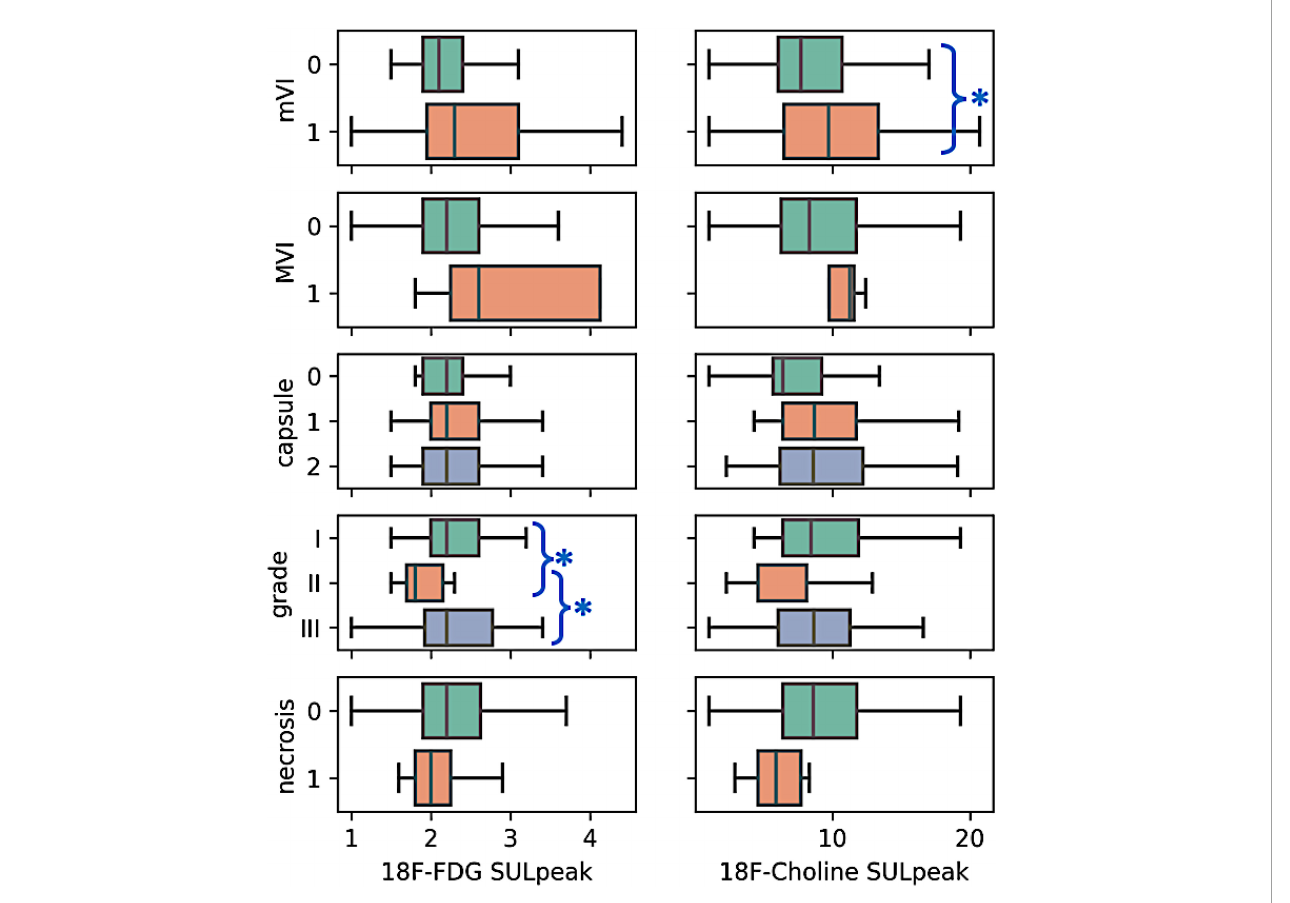
FIGURE3 Boxplot of the semi quantitative positron emission tomography (PET) data according to histological characteristics. Among the five histological characteristics, higher 18F- choline uptake was observed in the case of mVI positive tumors ( p < 0.05, non-parametric mann-whitney U test, blue asterisk). Also, 18F-FDG uptake between the Grades I–II and II–III was significant ( p < 0.05, non-parametric kruskal wallis ANOVA with post-hoc tests, blue asterisk). For the remaining macrovascular invasion (MVI), capsule (no, partial, total), and necrosis (absence, presence) characteristics, no difference in radiotracers uptake was observed between the tumor subgroups ( p > 0.05).